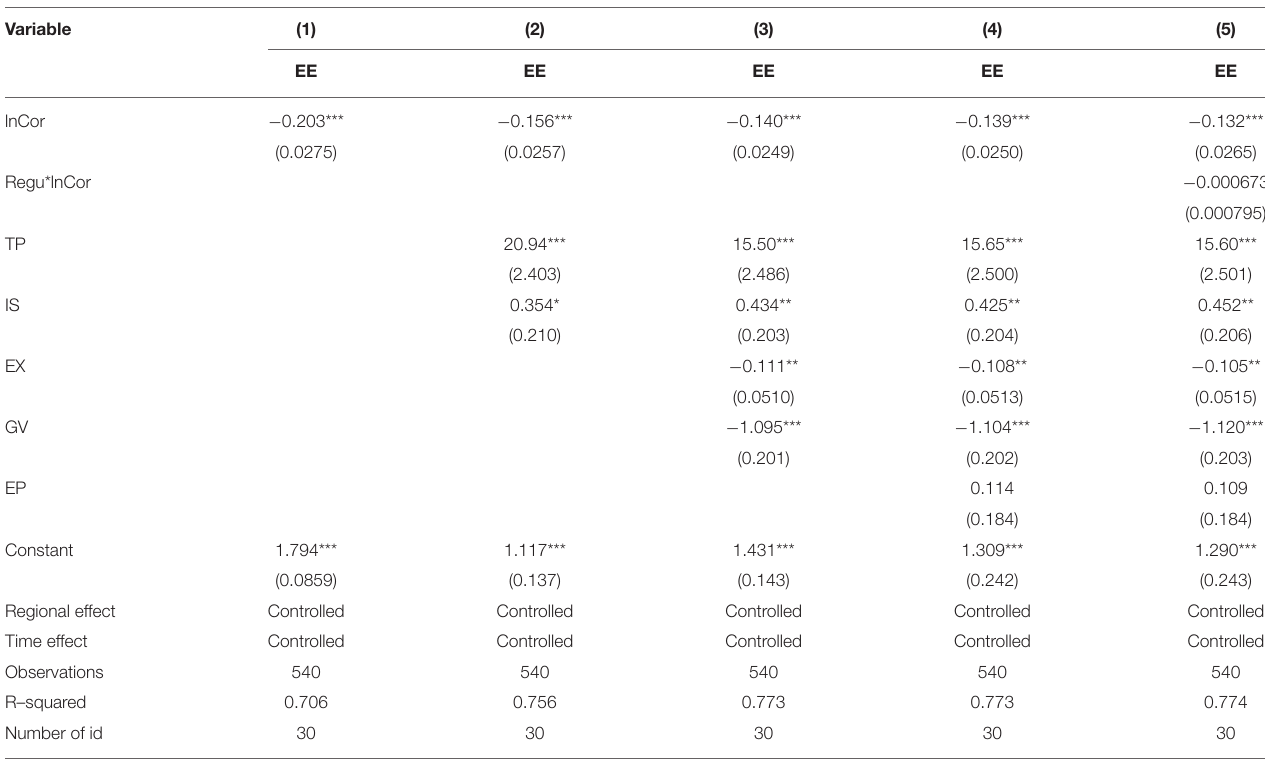
TABLE 6 | National regression results.